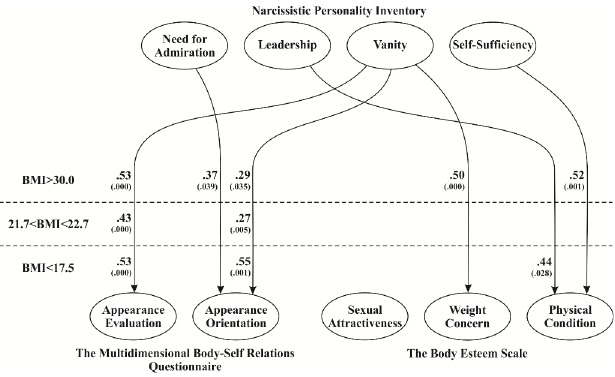
Fig 2. Analysis of multiple regression: influence of narcissistic traits on the self-perceived attractiveness of women from three BMI categories (obesity, “ ideal BMI ” , slim).